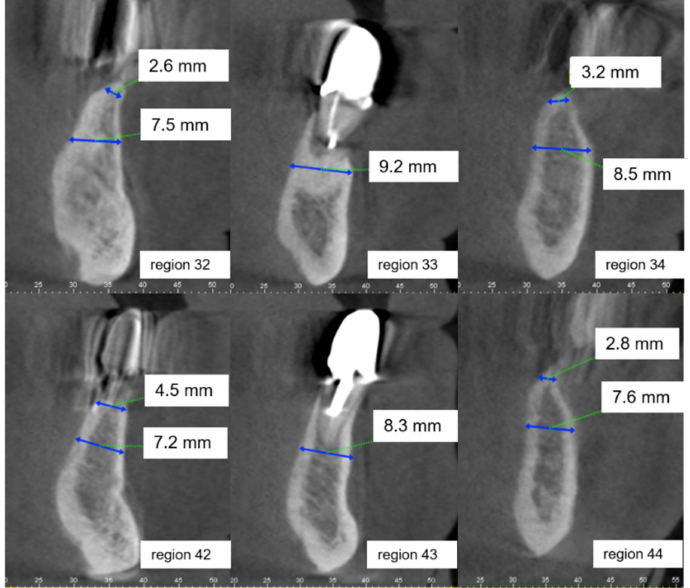
Figure 2. Sagittal plane from the CBCT of regions 32–34 and 42–44 of Case Vignette 1. The alveolar ridge is substantially atrophied in the crestal region. The widths of the alveolar ridge (mm = millimeters) are provided in the respective cut-outs. The alveolar ridge height is